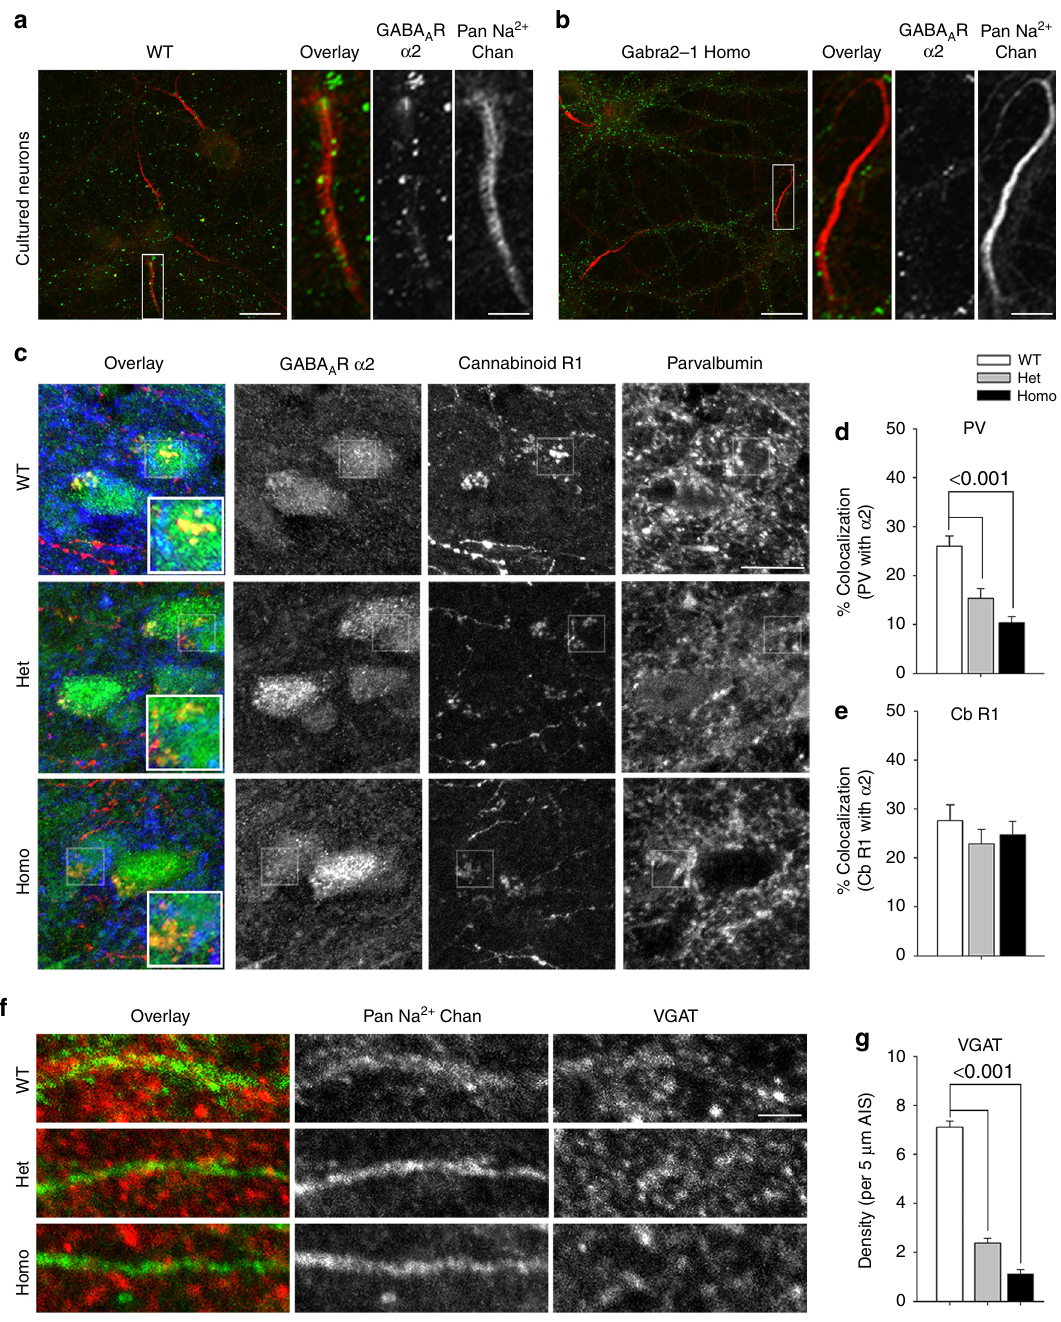
Fig. 6 Examination of the subcellular localization of GABA A R α 2-subunit clusters in Gabra2 -1 mice. Cultured cortical neurons from wildtype ( a ) and Gabra2- 1 homozygous ( b ) pups stained with antibodies directed against GABA A R α 2 (green) and sodium channels (red), showing zooms of representative AIS segments. c Colocalization of GABA A R α 2 (green) with CB1R (red) and parvalbumin (blue) clusters in the CA1 of wildtype, heterozygous and homozygous Gabra2 – 1 mice. Quanti fi cation of the colocalization of GABA A R α 2 with parvalbumin ( d WT — 26.05 ± 2.12; Het — 15.34 ± 2.06; Homo — 10.41 ± 1.24) and CB1R ( e WT — 27.64± 3.30; Het — 22.90 ± 2.99; Homo — 24.73 ± 2.74). f Staining for VGAT (red) positive clusters to mark inhibitory presynaptic compartments, along with a Pan-sodium channel antibody (green) to label the axon initial segment. g Quanti fi cation of the number of VGAT positive clusters per 5 µ m of AIS (WT — 7.11 ± 0.26; Het — 2.39 ± 0.19; Homo — 1.11 ± 0.18). Scale bar = 10 µ m (A low mag, C), scale bar = 5 µ m (A zoom, F). All plots shown and all values listed are mean ± standard error, p values from